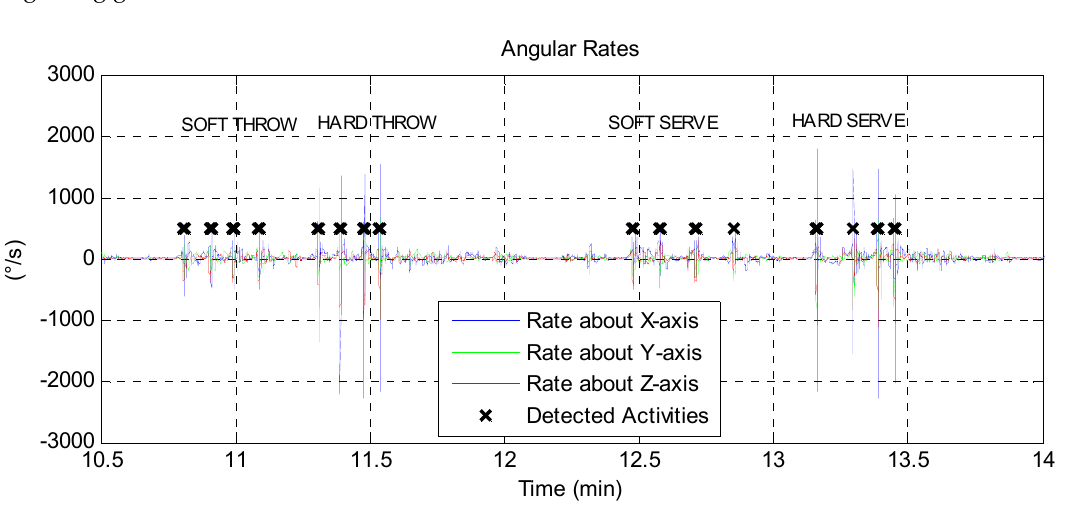
Figure 7. First stage detector for sport activities applied to a data segment (angular rates shown here). The segment contains 8 repetitions of baseball throws and volleyball hits (at varying intensities). X -marks indicate the condition: ((Elevation of Arm > 45°) AND (Angular Rate Magnitude > 400°/s)).